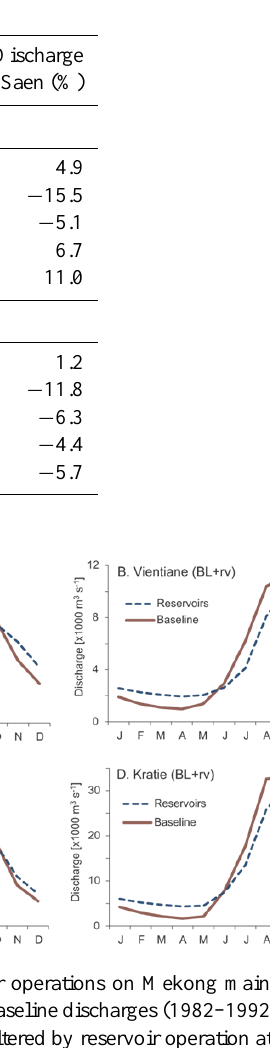
different GCMs (Fig.